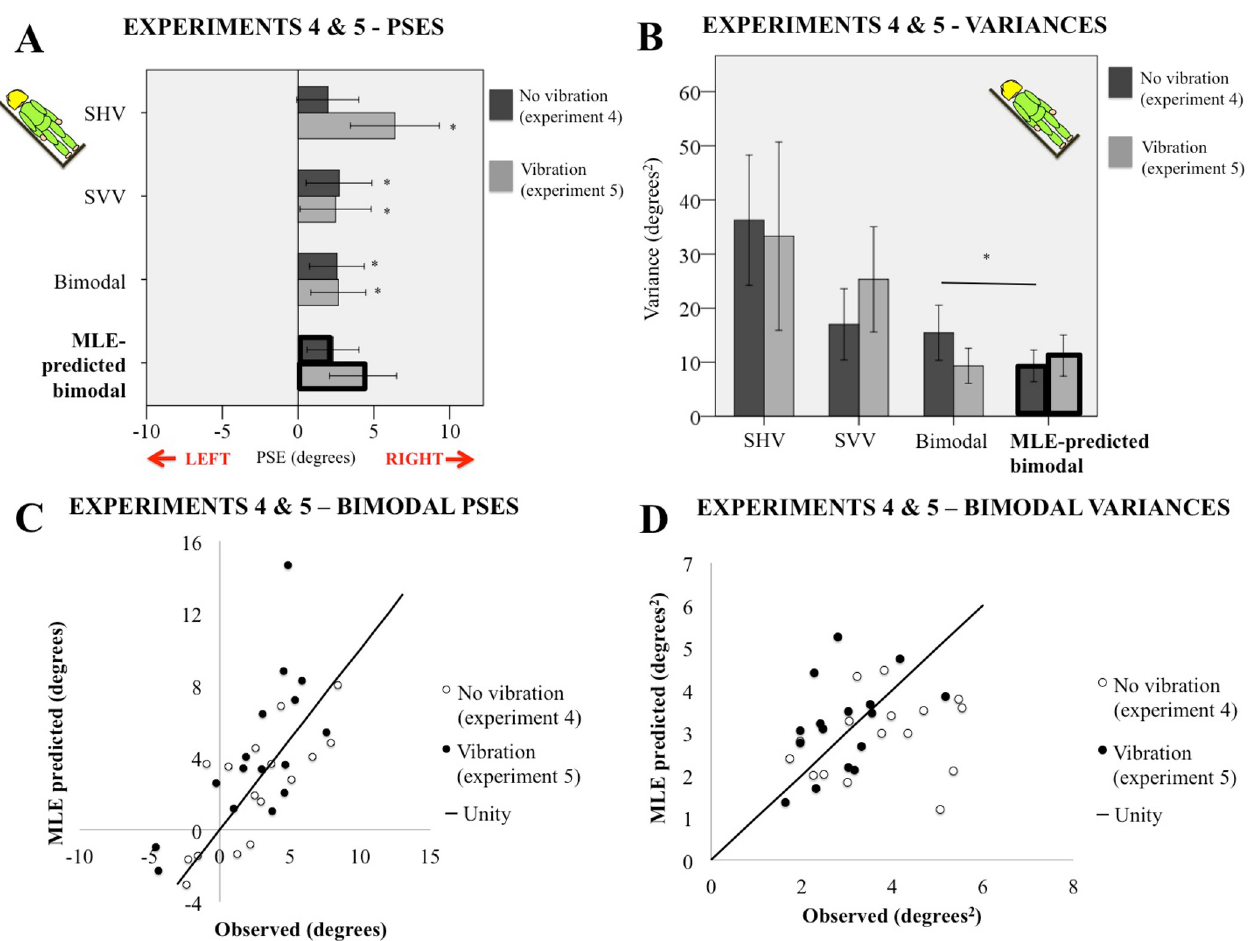
Fig 3. Results for experiments 4 and 5. A. Mean PSEs for SVV (with a blurry visual stimulus), SHV and bimodal measures for experiment 4 (dark grey bars), and experiment 5 (with neck vibration, light grey bars). PSEs predicted by the maximum likelihood estimate (MLE) model for each experiment are bolded. 0° corresponds to gravitational vertical. Asterisks indicate mean was significantly different from 0° at p < 0.05. Error bars are 95% confidence intervals. B. Mean variance for all three modalities, with and without neck vibration. Error bars are 95% confidence intervals. MLE-predicted values are outlined in bold. C. Observed bimodal PSEs versus MLE predicted bimodal PSEs for each participant, for experiment 4 (open circles) and experiment 5 (filled circles). Solid line indicates a slope of 1. D. Observed variances of the bimodal measure versus predicted variances, for experiment 4 (open circles) and experiment 5 (filled circles). Solid line indicates a slope of